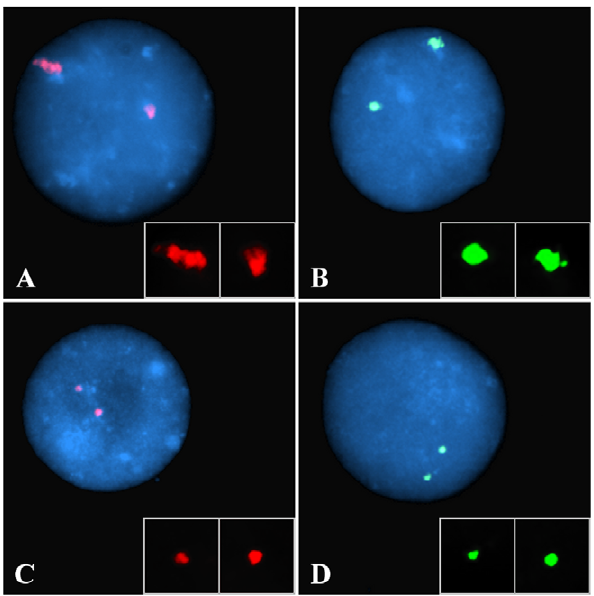
Figure 1. Visualisation of the juxtacentromeric heterochroma- tin in the cell nucleus. Chromosome 1 and chromosome 16 juxtacentromeric heterochromatic regions were visualised by hybridis- ing to interphase nuclei (counterstained with DAPI) (blue) the classical satellite DNA probes D1Z1 (red) and D16Z3 (green), respectively. Evaluation of the hybridisation signals on a cell-by-cell basis allowed the identification of a pronounced inter-nuclear and inter-allelic variability in the heterochromatin patterns within each of the cell populations (either patients or controls). Above are examples of two easily distinguishable configurations: ‘‘conventional’’ (the fluorescent signal is typically conspicuous and its outline is uneven) (A and B) and ‘‘compact’’ (the fluorescent signal is conspicuously smaller and its outline well defined) (C and D). Single channel images were imaged using a monochrome CCD camera attached to a wide-field fluorescence microscope, pseudocoloured and merged. Insert boxes within each image show the heterochromatic signal digitally enhanced.